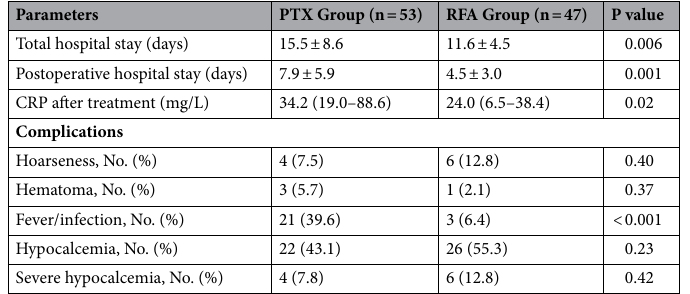
Table 3. Comparison of safe between PTX and RFA group. Hypocalcemia < 2.0 mmol/L; Severe hypocalcemia < 1.8 mmol/L.